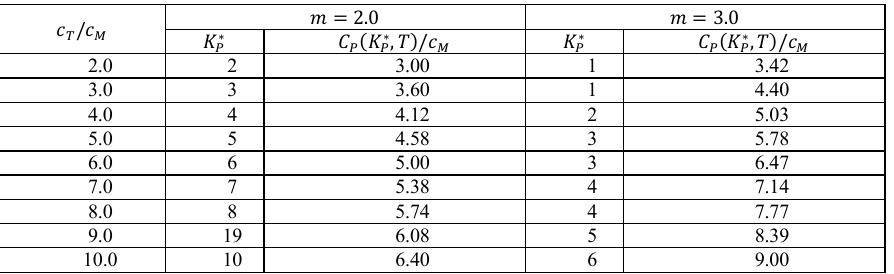
Table 4. Optimum 𝐾 𝑃∗ and its cost rate when 𝐻(𝑡) = 𝑡 𝑚 and 𝑇 =